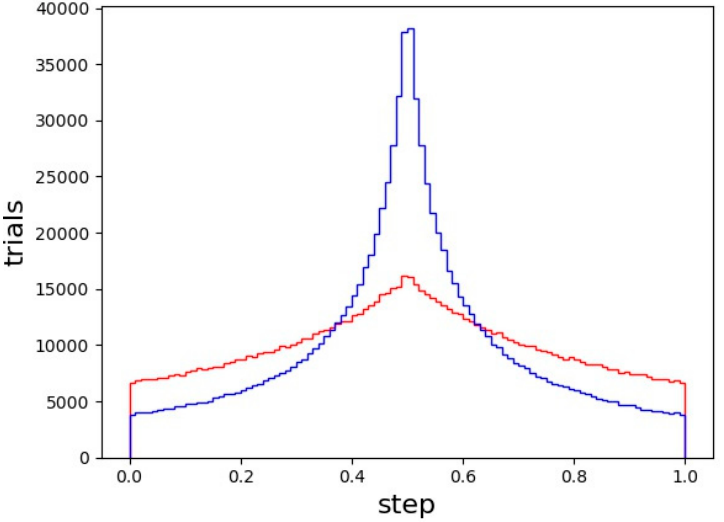
Figure 2. Temperature dependent random step distribution used for MCSA calculations in GSAS-II for T = 0.7 (red) and T = 0.1 (blue) for 1,000,000 trials. The steps are then scaled to the parameter ranges to give the values used in each MCSA trial.